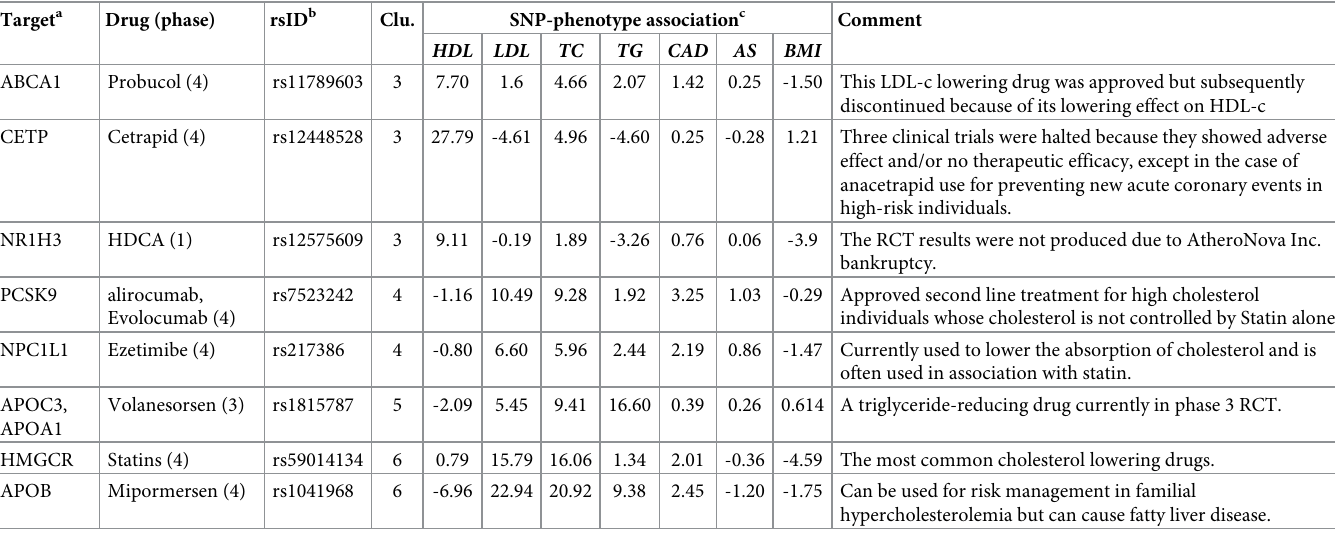
Table 2. Drug target genes and associated SNPs in the metabolism set Target